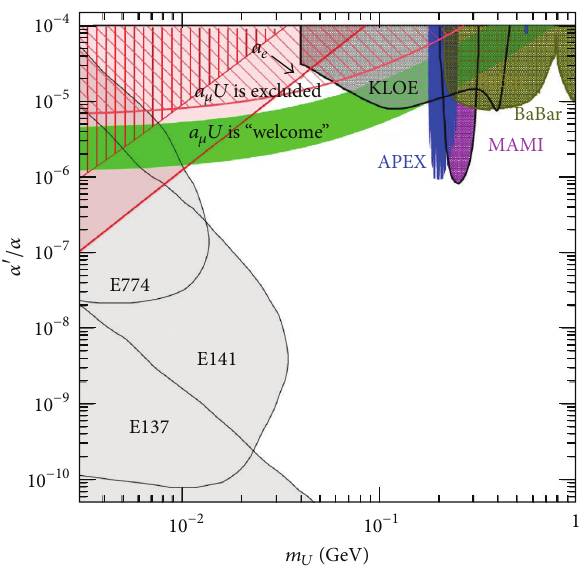
Figure 2: Exclusion region in the hypothesis of decay into lepton pairs.